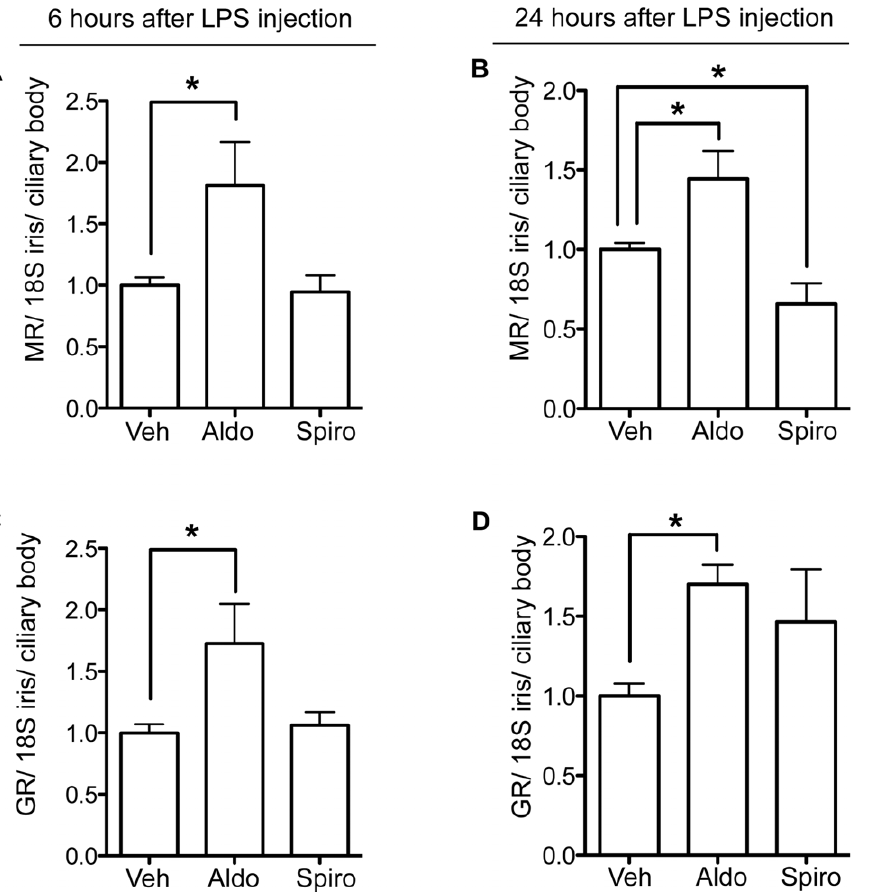
Figure 5. MR and GR mRNA expression after intravitreal injection of aldosterone or spironolactone in the eye of LPS-injected rats. EIU was associated to down-regulation of MR and GR (Fig. 1). A–B: MR expression in iris/ciliary body (real-time PCR): In the inflamed eye, intravitreal injection of aldosterone (Aldo) increased MR transcripts at 6 hours (A) and 24 hours (B) in EIU vs vehicle-injected eyes (Veh). Intravitreal injection of spironolactone (Spiro) decreased MR transcripts compared to vehicle-injected rats at 24 hours (B) and had no effect at 6 hours (A). C–D: GR expression in iris/ciliary body (real-time PCR): In the inflamed eye, intravitreal injection of aldosterone increased GR transcripts at 6 hours (C) and 24 hours vs vehicle-injected eyes (D). GR expression was not statistically modified by spironolactone. The 18S was used as housekeeping gene. Results are relative values of aldo/spiro relative to vehicle injection. Data are means 6 SEM; n=5–7 rats per condition; *p , 0.05.